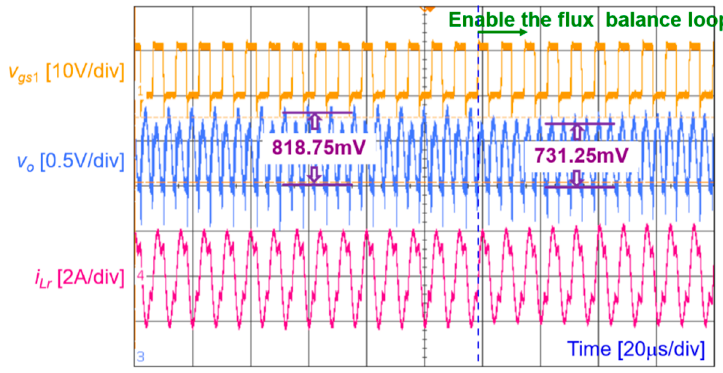
Figure 23. Experiment results of the disabled / enabled flux-balance loop at 70% load, considering the mismatched secondary side leakage inductances.